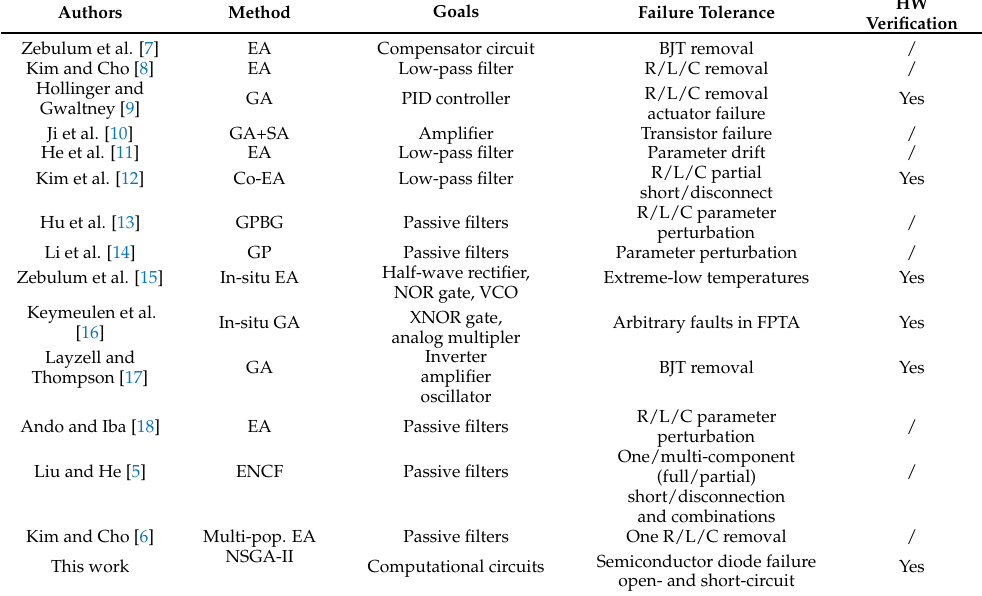
Table 1. Previous work on the evolutionary synthesis of analog circuits for robust design and fault